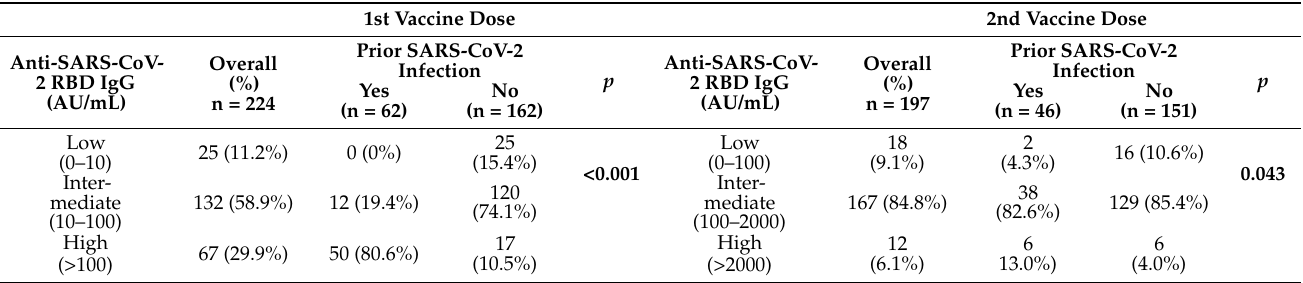
Table 4. Anti-SARS-CoV-2 RBD IgG titer quantification after the first and second vaccine dose, overall and stratified according to prior SARS-CoV-2